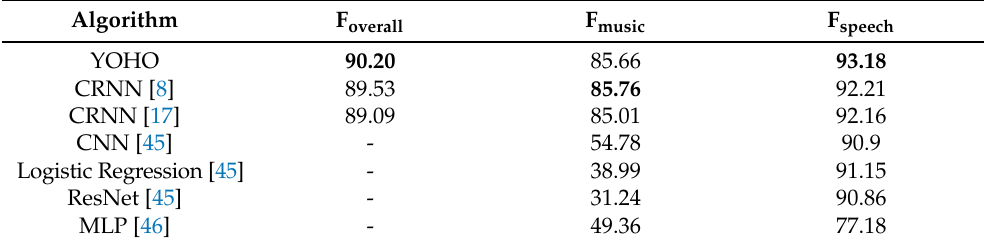
Table 6. Evaluation on the MIREX music-speech detection dataset 2018. The results of other studies were obtained from the MIREX website [27]. The F-measures are presented as percentages. The values in bold indicate the largest number in each